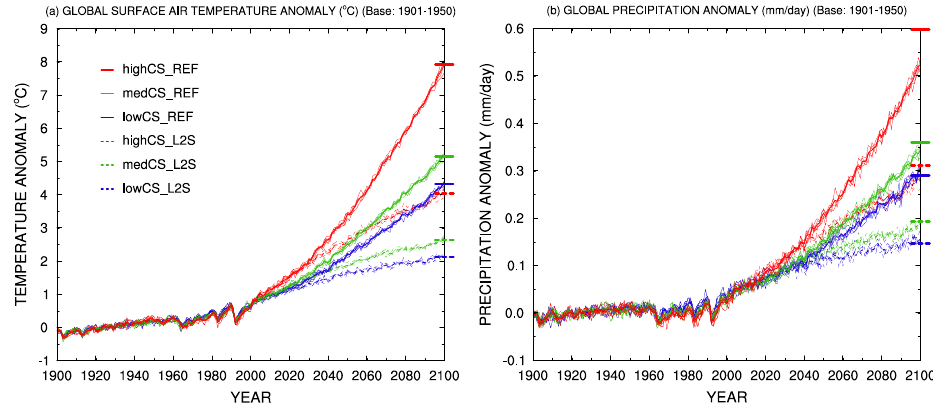
Fig. 13. Global mean (a) surface air temperature anomalies ( ◦ C) and (b) precipitation anomalies (mmday − 1 ) from the 1901–1950 mean for the IGSM-CAM simulations. The reference (REF) and stabilization (L2S) scenarios are represented by, respectively, solid and dashed lines. The simulations with a climate sensitivity of 2.0, 2.5 and 4.5 ◦ C are shown respectively in blue, green and red. The thin lines represent each of the five-member ensemble with different initial conditions and random wind sampling while the thick lines represent the ensemble means. The 2100 anomalies from the stand-alone IGSM2.3 simulations with the same climate parameters and emissions scenarios are represented by the horizontal lines on the right y